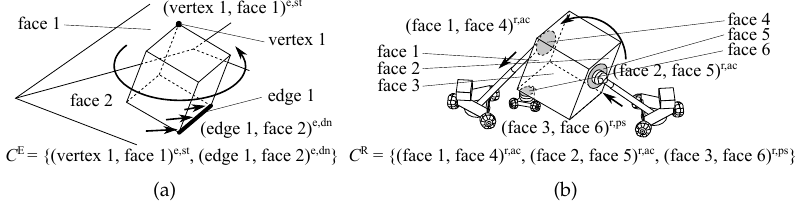
Figure 3. Examples of contact formation (CF): ( a ) environmental contact formation (ECF) when a cuboid contacts with two surfaces of the environment by its vertex and edge; ( b ) robot contact formation (RCF) when a cuboid contacts with two active robots and a passive robot by its